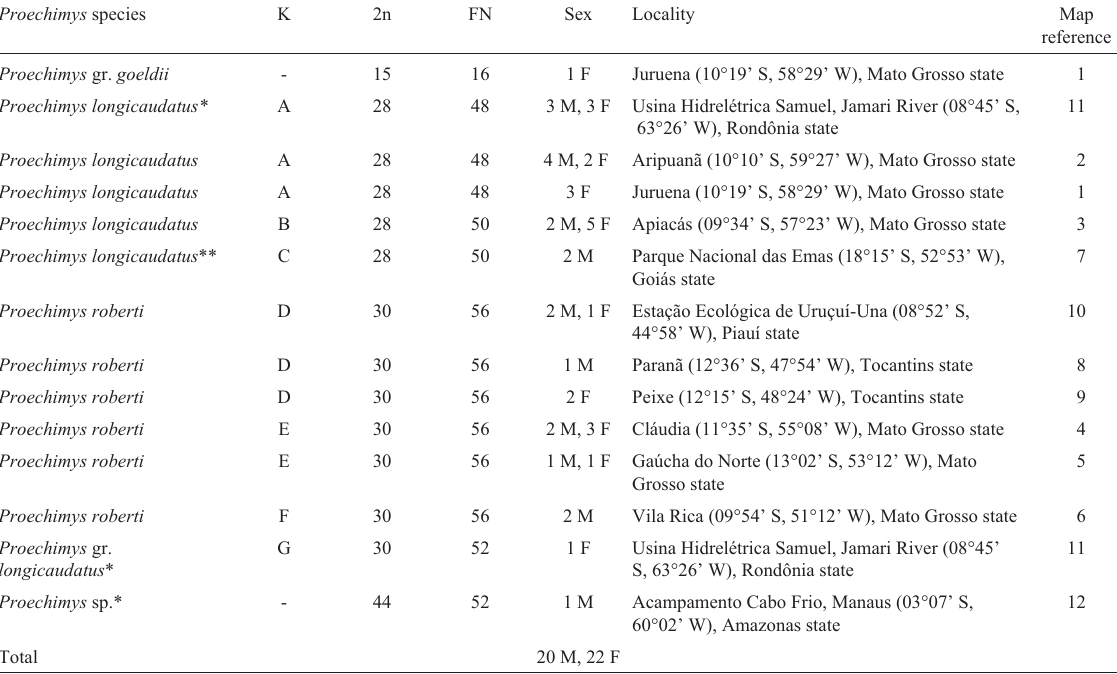
Table 1 - Species, karyomorph (K), diploid number (2n), fundamental number (FN), sex (female = F; male = M), locality and number of the localities shown on the map (Figure 1). Proechimys species